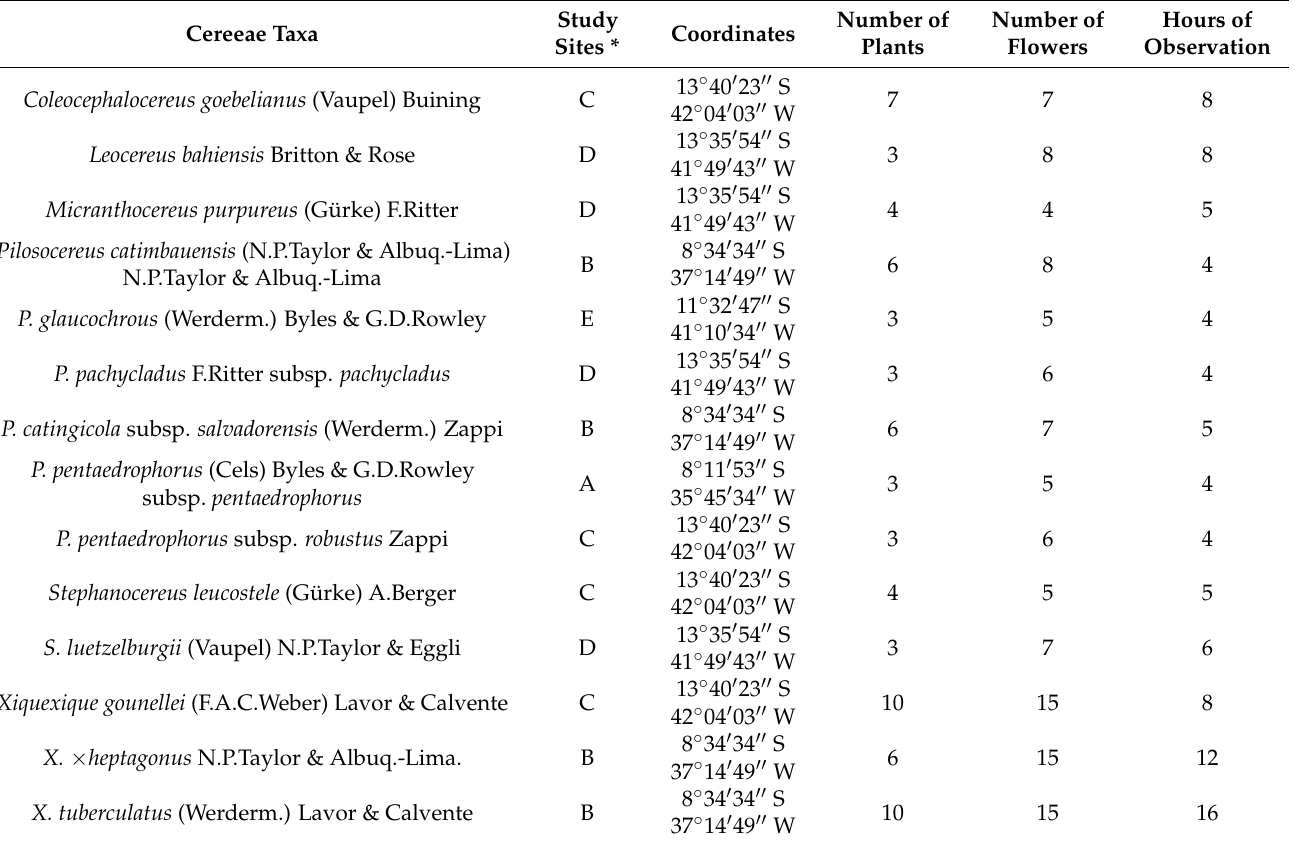
Table 1. List of taxa of Cereinae (Cactaceae) studied, study sites, coordinates, number of plants and flowers studied, and hours of observation of floral visitors in the field. Cereeae Taxa